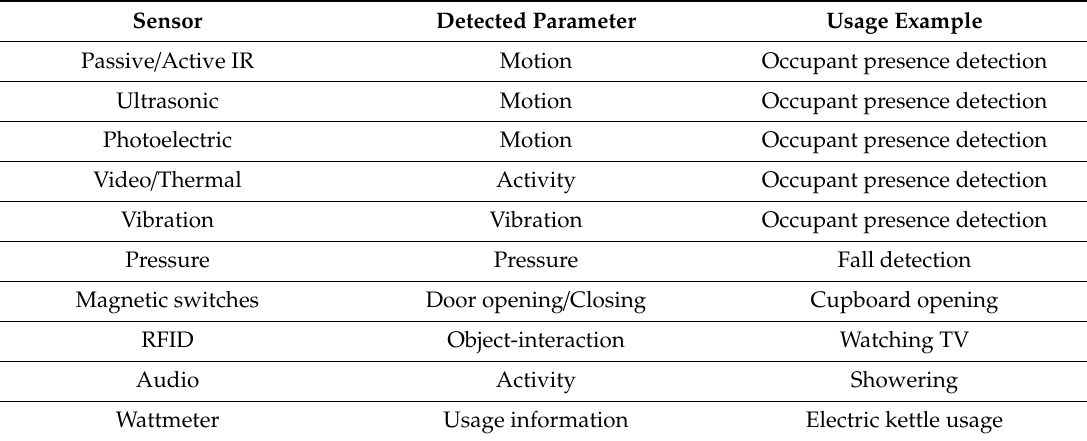
Table 5. Nonwearable sensors used for activity